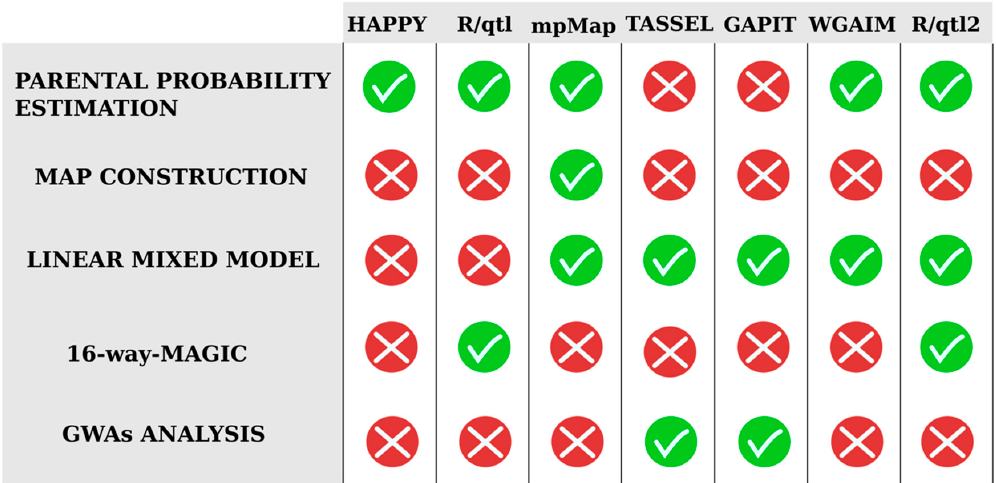
Figure 6. Analysis software used for QTL analysis in the available MAGIC populations, indicating the type of functionalities and analyses that can be performed in each of them.